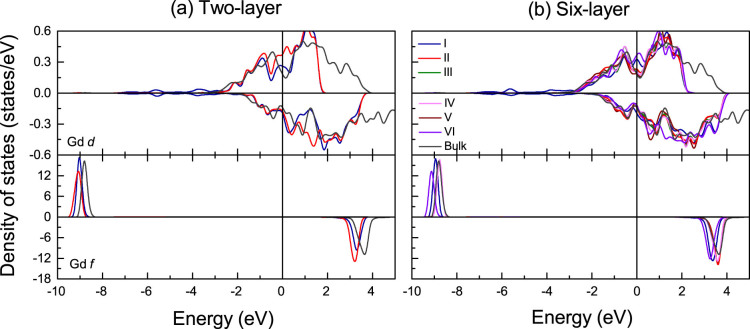
DOS of the Gd atoms in the different atomic layers of the two- and six-layer Gd/MoS2 interfaces.EF = 0 eV.